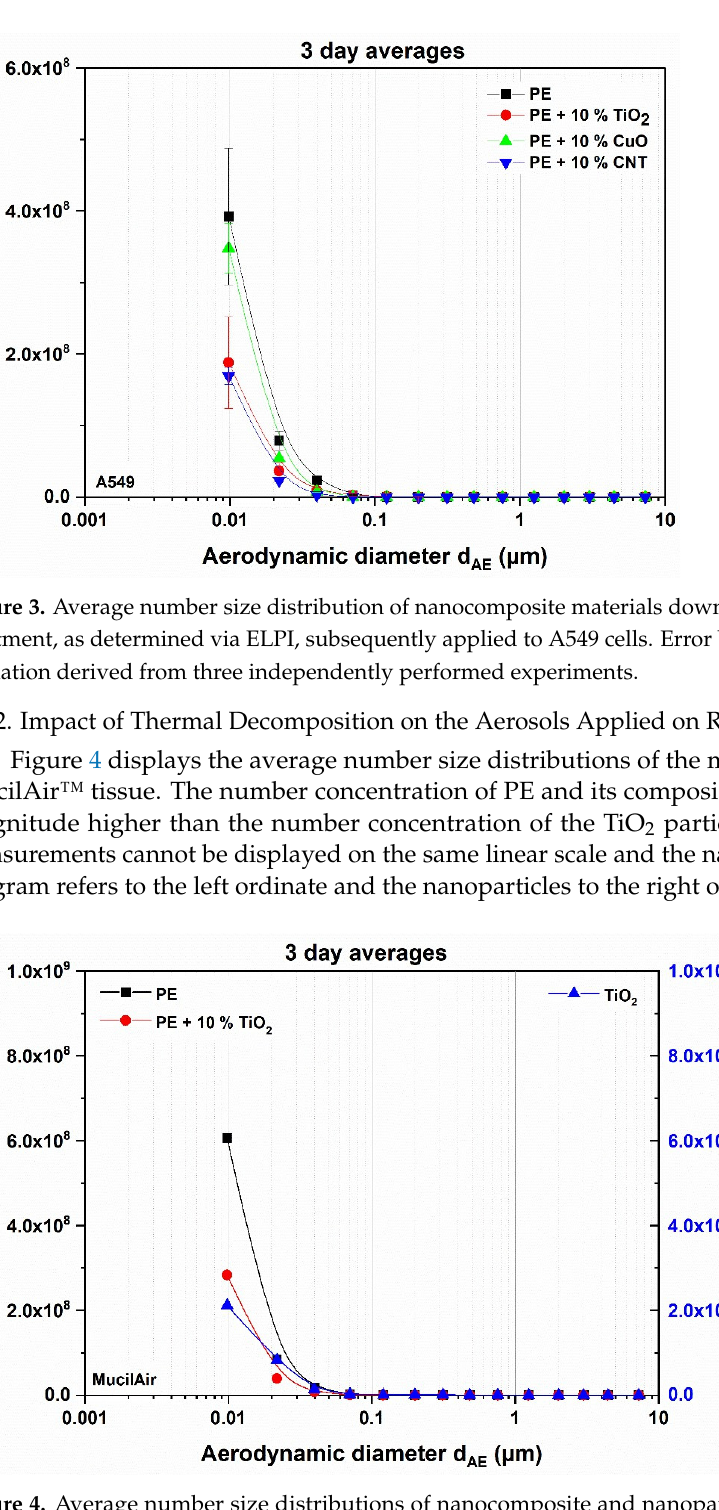
Figure 2. Average measured number size distributions of the different nanomaterial suspensions downstream of the thermal treatment, as determined via ELPI, subsequently applied to A549 cells. Error bars indicate standard deviation derived from three independently performed experiments.